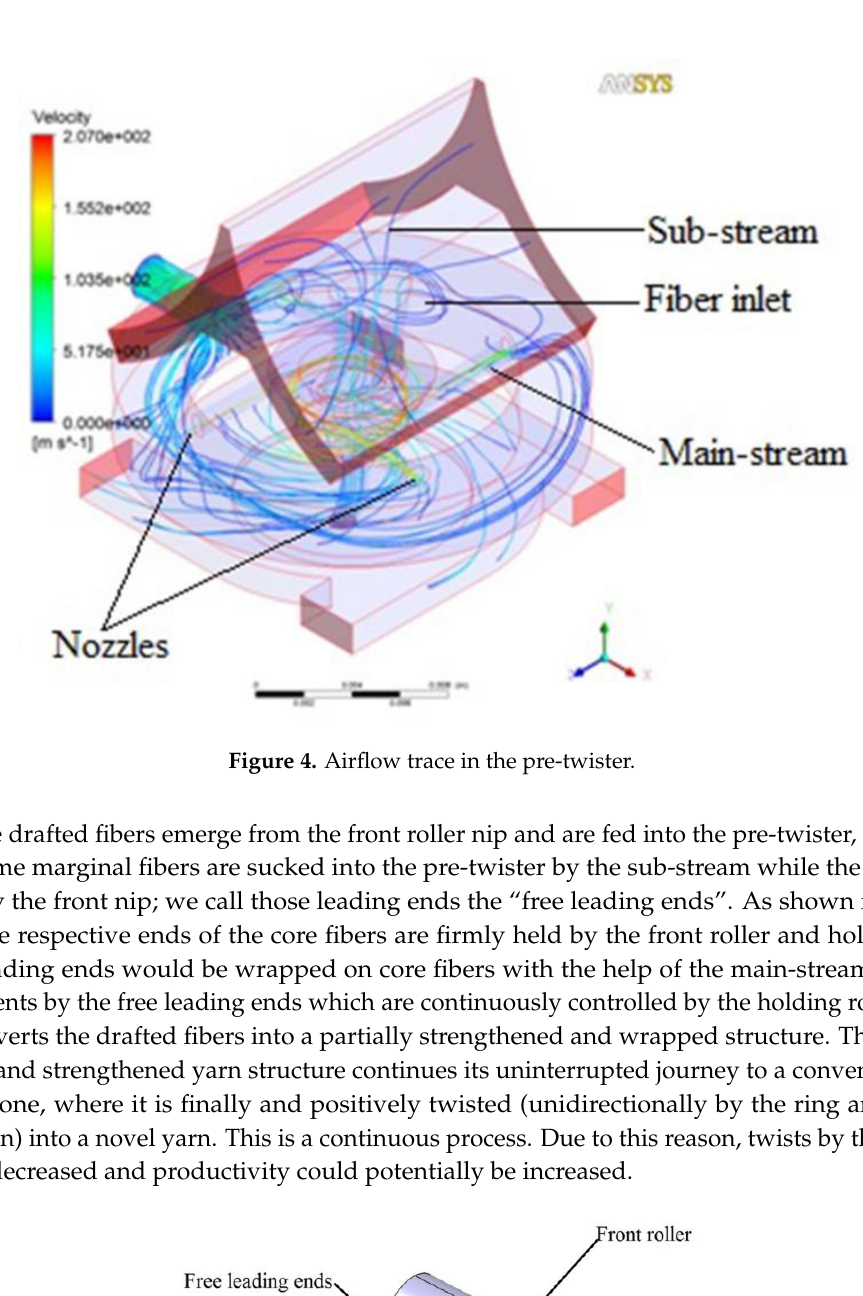
Figure 5. The pre-twisting process. The characteristics of the airflow in the pre-twister for each case in Table 1 were simulated, and are shown in Figures 7 – 10. The air field can be described with the airflow trace and its velocity which will directly influence the wrapping effect of the pre-twister. The air velocity is resolved into three components, viz., tangential velocity (V x ), radial velocity (V y ), and axial velocity (V z ), as shown in Figure 6. Wrapping action is created by the tangential and axial velocity components of the air velocity. The total width of the drafted fibers emerging from the front roller nip is 2~4 mm (varied by the roving count), so the distance from core to marginal fiber is 1~2 mm. Thus, on the radial direction along the axis 1 and 2 mm away from it, the tangential and axial velocities from inlet to outlet are discussed.